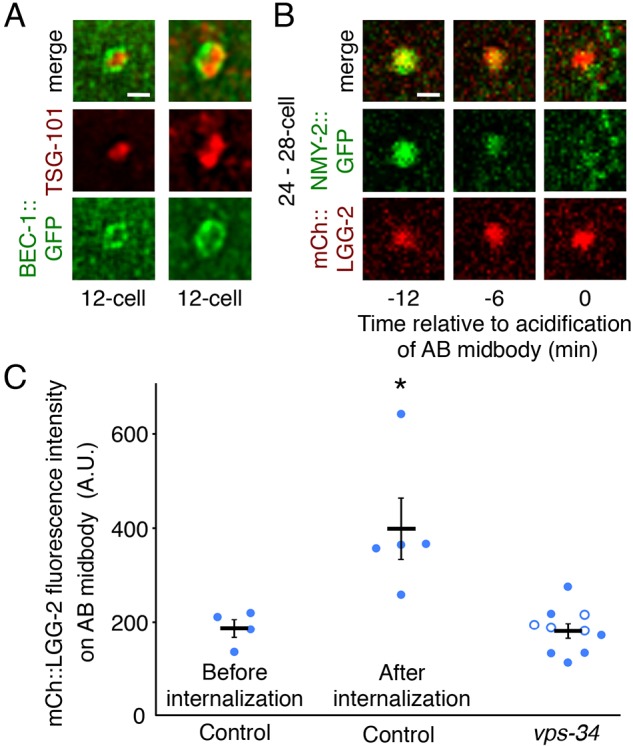
Beclin 1 and LC3 homologs localize to the midbody phagosome. (A) BEC-1::GFP (green) staining surrounds midbodies (TSG-101, red) after internalization (n=5/22 embryos). Antibody staining was performed in triplicate. (B) mCh::LGG-2 (red) localizes on midbodies (NMY-2::GFP, green, n=12/14) and persists after acidification. Scale bars: 1 μm (A,B). See also Fig. S3. (C) mCh::LGG-2 is significantly enriched on midbody phagosomes after internalization (n=4 before internalization, n=5 after internalization, *P<0.05 compared to midbodies before internalization). mCh::LGG-2 enrichment does not occur in vps-34 mutants [n=6 released (solid blue circles), n=4 internalized midbodies (open blue circles)]. Results are mean±s.e.m. Student's t-test with Bonferroni correction was used for statistical analysis.